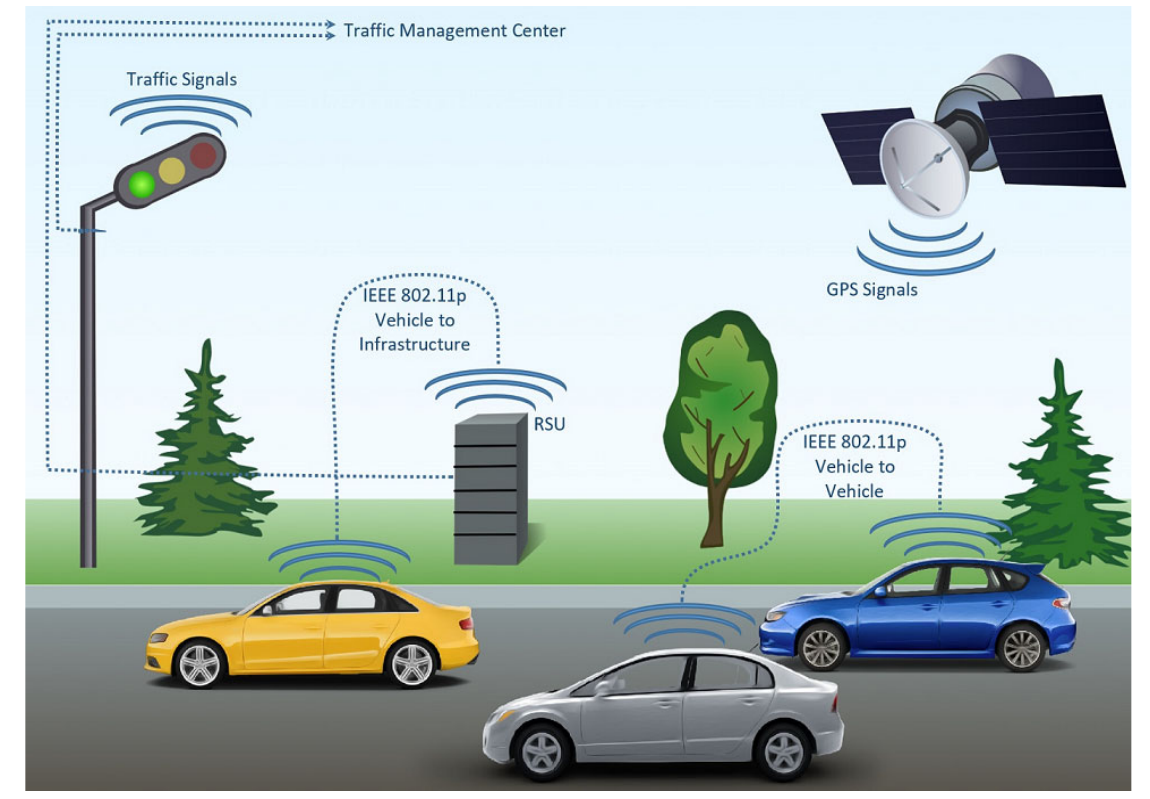
Figure 1. VANET’s architecture.